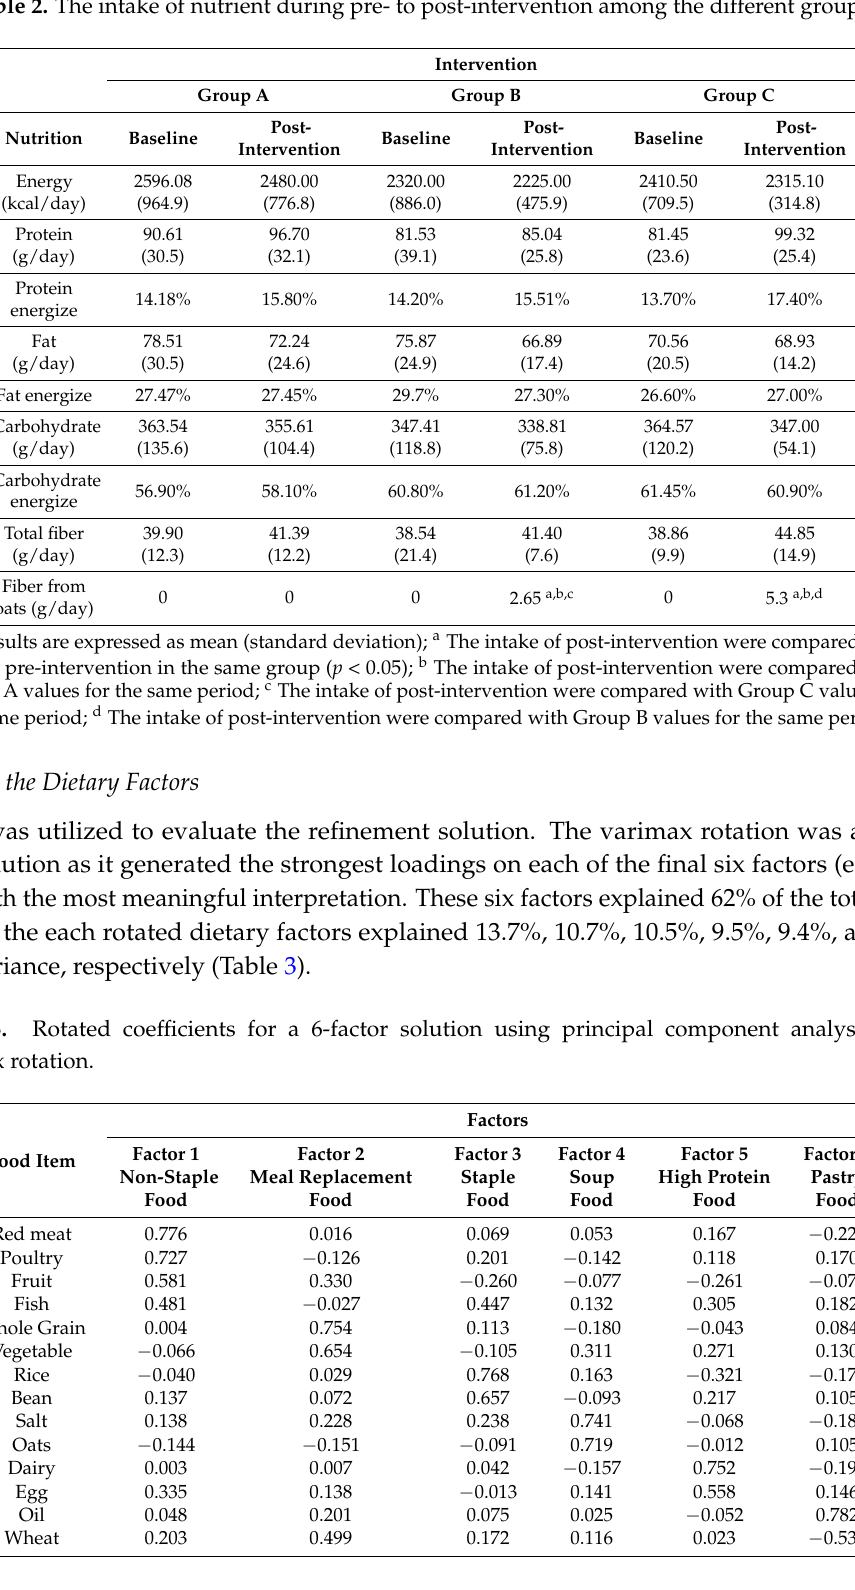
Table 2. The intake of nutrient during pre- to post-intervention among the different groups.